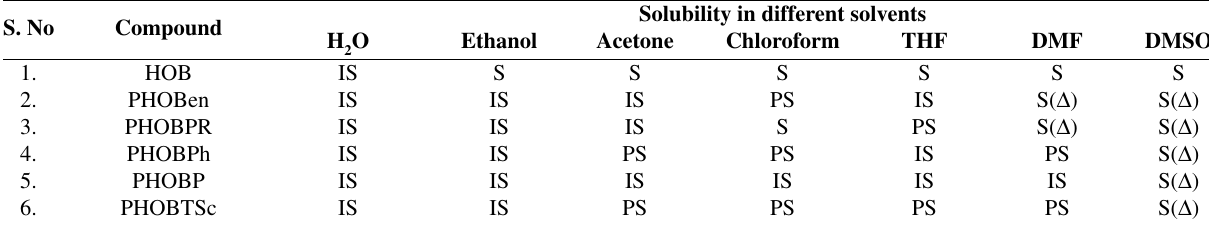
Table 1: Solubility of monomer (HOB) and polymers in different solvents at the concentration of 5mg/ 5ml S.